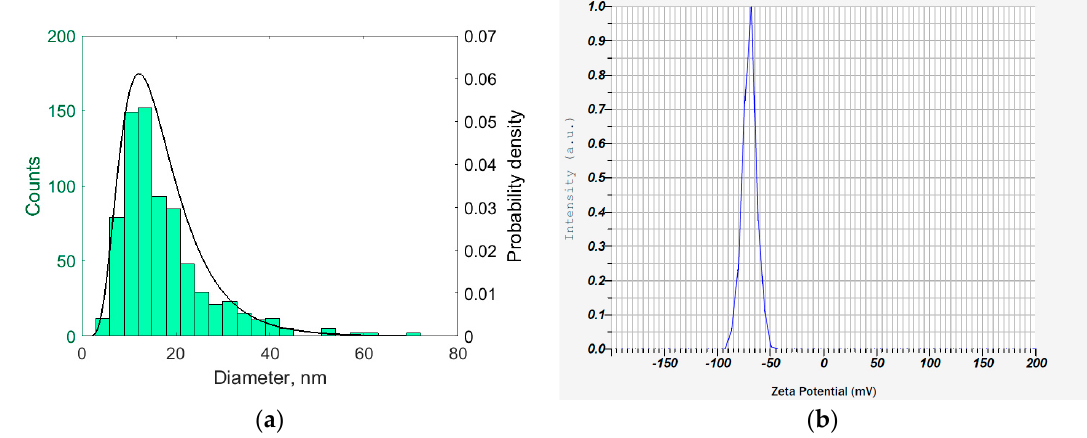
Figure 2. ( a ) Diameter distribution of cellulose nanofibrils; ( b ) Zeta potential distribution of cellulose nanofibrils.